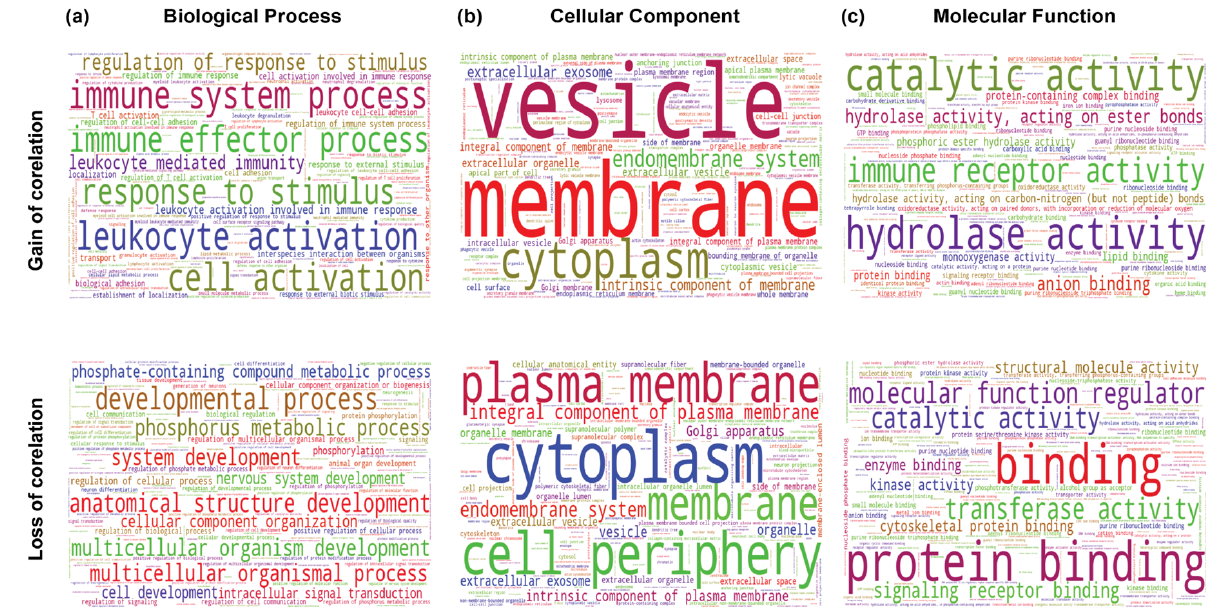
Figure 13. Gene Ontology analysis of genes differentially correlated with THAP9-AS1 in normal vs. tumor samples (top—genes that gained correlation with THAP9-AS1; bottom—genes that lost correlation with THAP9). Word clouds of enriched ( a ) GO biological process, ( b ) GO cellular component, and ( c ) GO molecular functions. The differential gene correlation analysis, followed by